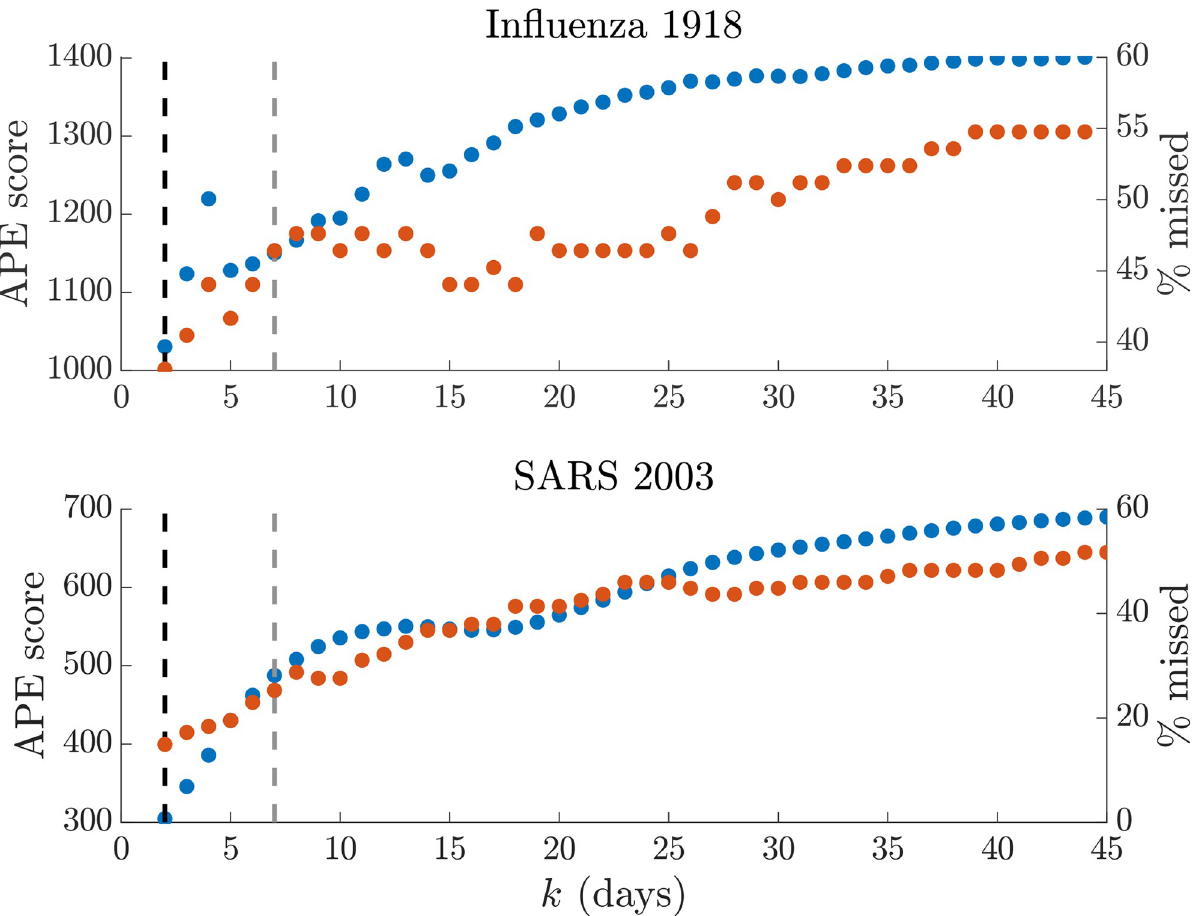
Fig 8. Empirical prediction accuracy. We compare the APE metric (dotted blue, left y axis) to the percentage of true incidence values, I outside the 95% prediction intervals of x j I s (dotted red, right y axis) across the window search space k . The dashed line gives k � (black) and k = 7 s (cid:0) k þ 1 (grey). The top graph presents results for the influenza 1918 dataset, while the bottom one is for SARS 2003 data. We find that heuristic weekly windows lead to appreciably larger forecasting error than the APE